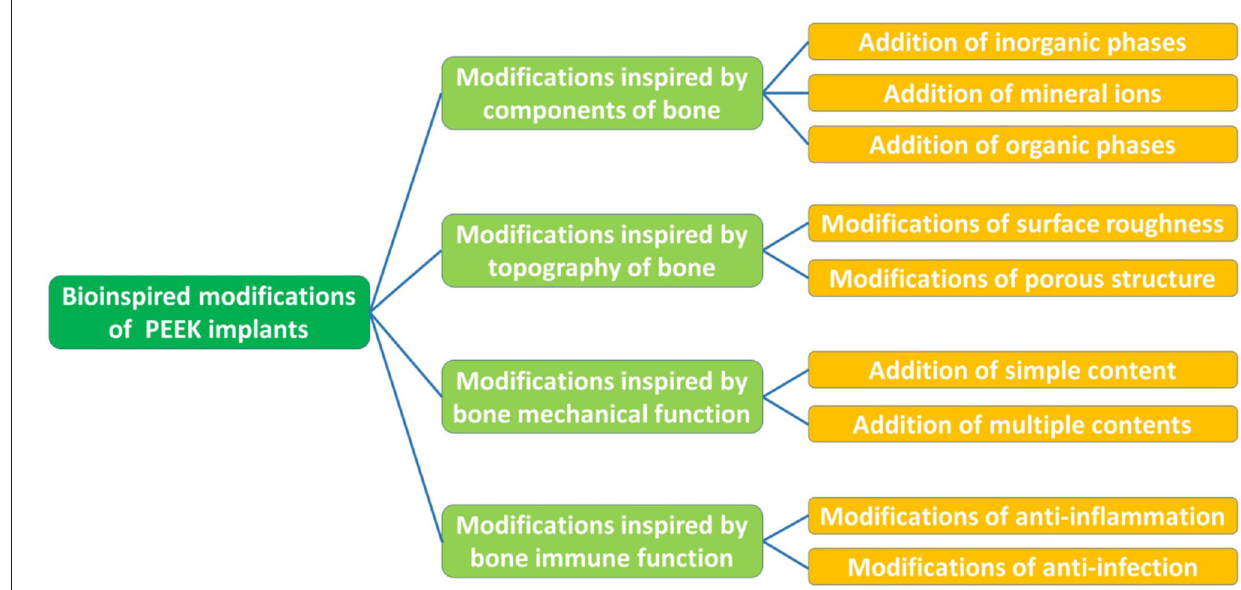
FIGURE 1 | Summary of bioinspired modifications of PEEK